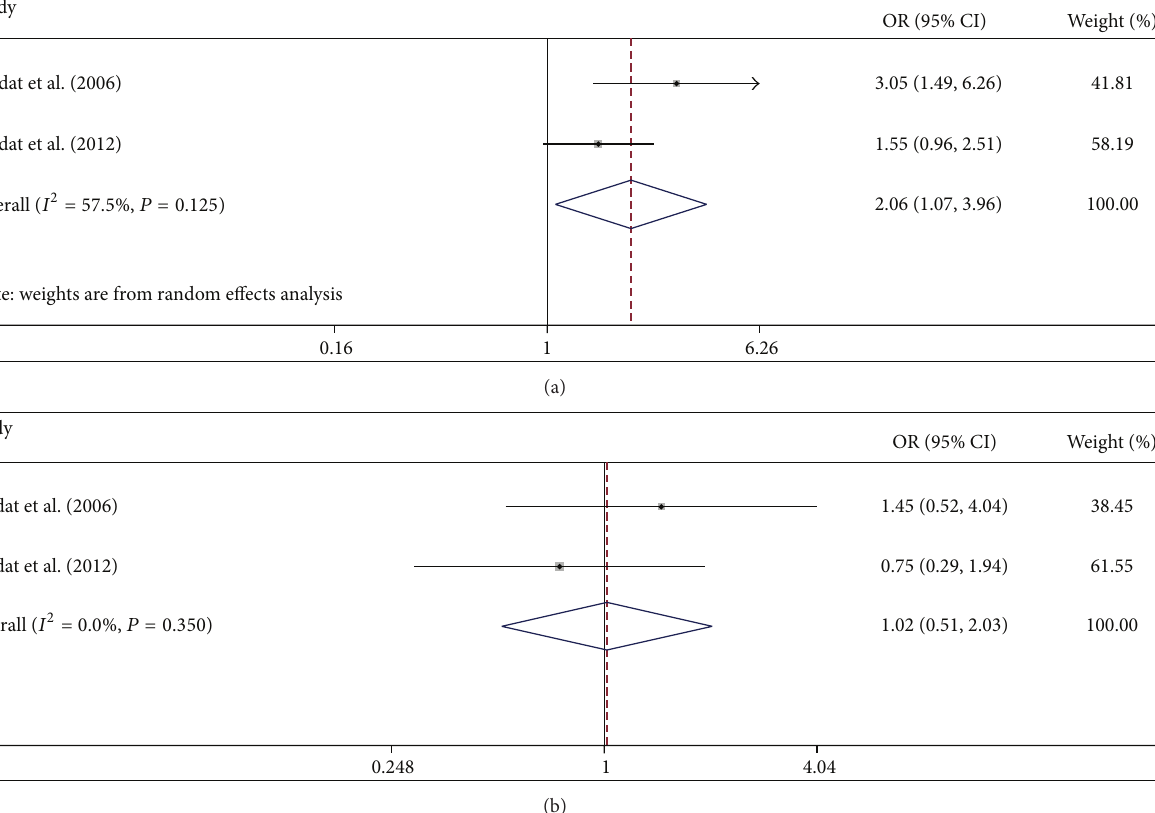
Figure 5: Working place-based subgroup analysis of the correlation between GSTM1/T1 null genotype and age-related cataract (ARC). (a) The association between GSTM1 null genotype and ARC in indoor subjects. (b) The association between GSTM1 null genotype and ARC in outdoor